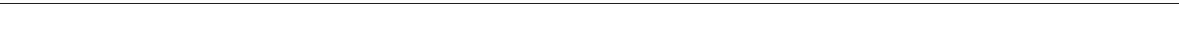
Fig. 1 Pioneering axons establish regenerative path for follower axons. a – e Images from time lapse movie showing early regeneration of wild-type motor nerve with all axons expressing GFP. a Pre-lesion image; yellow box marks transection site. b A pioneering axon (magenta arrowhead and ‘ P ’ ) crosses the injury gap ~800 min post-injury and extends ventrally. c , d , e Follower axons fasciculate with pioneering axon (numbered green arrowheads). f – j Still images from time lapse movie showing early regeneration of 5 dpf wild-type motor nerve; all axons express GFP, single-axon expresses mKate (magenta). f Pre-lesion image; yellow box marks transection site. Scale bar is 10 µ m. g Axon sprouts in proximal nerve stump start extending and retracting ~400 min post transection. h Single-pioneering axon (magenta) crosses the injury gap and extends ventrally along distal nerve by 800 min post transection. Magenta arrowheads mark pioneer axon, which grows at a rate of 0.27 µ m/min. i Follower axon extends and grows along pioneering axon; green arrowheads mark follower path, which grows at a rate of 0.36 µ m/min. j By the end of imaging, the magenta pioneer axon has extended ventrally, as shown via a maximum projection image across time (magenta arrowheads). k – o Still images from time lapse movie showing early regeneration of lrp4 mutant motor nerve labeled with GFP. k Pre-lesion image; yellow box marks transection site. l Early growth cones sprout from proximal stump (open blue arrowheads) and pioneer axon extends ventrally ~600 min post transection (magenta arrowhead and ‘ P ’ ). m – o Throughout imaging, only the pioneer axon extends to ventral myotome; follower axons explore transection site but do not traverse injury gap (open blue arrowheads). p Quanti fi cation of pioneer axon growth rate and follower axon growth rate in wild-type siblings. Pioneer axon average rate of regrowth is 0.24 µ m/min ( n = 12 nerves in 8 larvae); follower axon average rate of regrowth is 0.47 µ m/min ( n = 7 nerves in 4 larvae; unpaired t -test p = 0.0055; t = 3.181, df = 17; error bars show mean and SEM). q Quanti fi cation of pioneer axon rate of regrowth in siblings and lrp4 mutants. Pioneer axons grow at equivalent rates: sibling average rate of regrowth = 0.24 µ m/min ( n = 12 nerves in 8 larvae); lrp4 − / − average rate of regrowth = 0.21 µ m/min ( n = 10 nerves in 4 larvae; unpaired two-tailed t -test p = 0.4702, t = 0.7361, df = 20; error bars show mean and SEM). r Number of follower axons in siblings and lrp4 mutants. In siblings, multiple follower axons extend (average number of follower axons = 2.2, n = 6 nerves in 2 larvae) while in lrp4 mutants, follower axons fail to extend ventrally ( lrp4 mutant average number of follower axons = 0.7, n = 7 nerves in 2 larvae). Number of follower axons in siblings versus mutants is signi fi cantly different (two-tailed t -test p = 0.0206, t = 2.703, df = 11; error bars show mean and